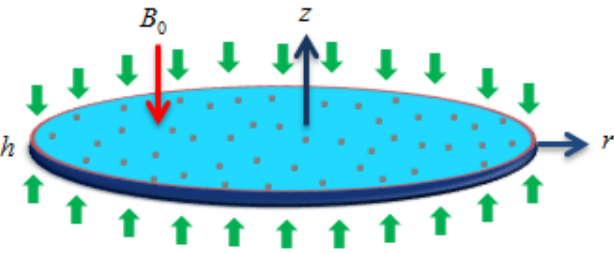
Figure 1. Geometrical illustration of the problem.